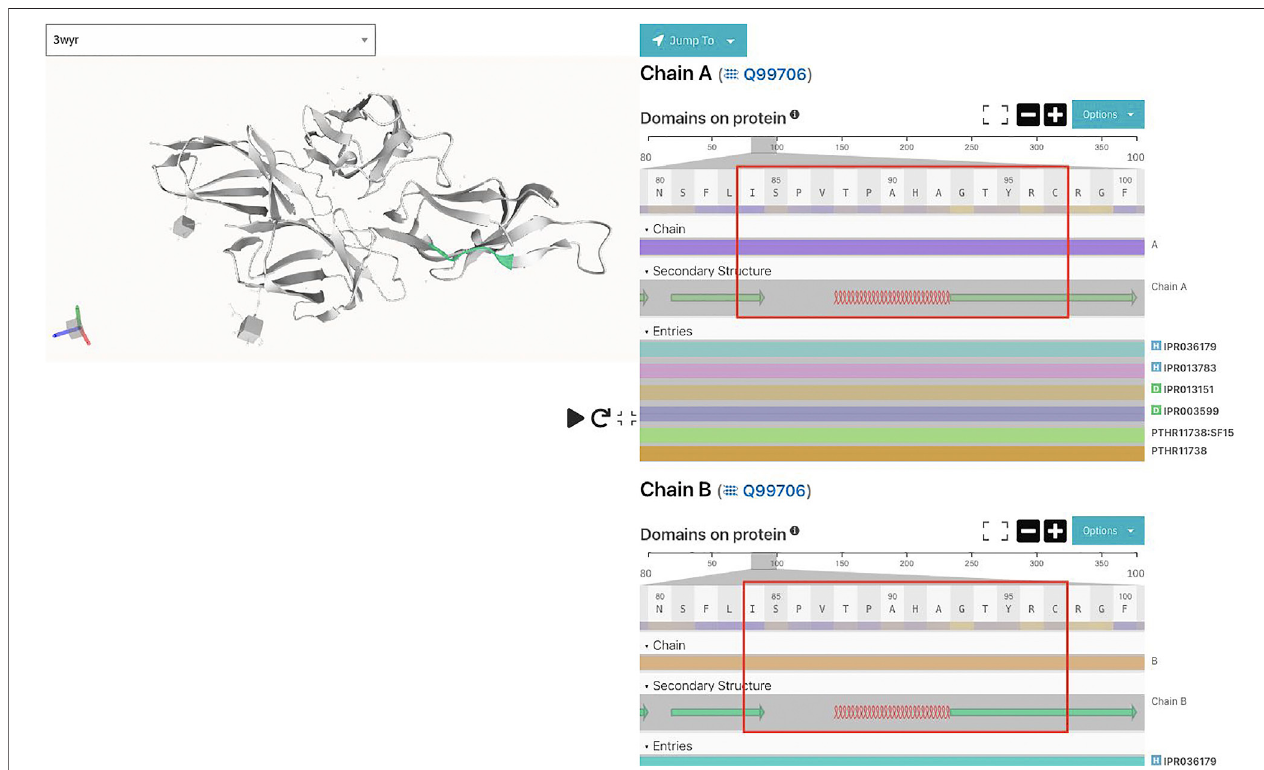
FIGURE 5 | Shared motif and its secondary structure (from PDB entry 3wyr) using